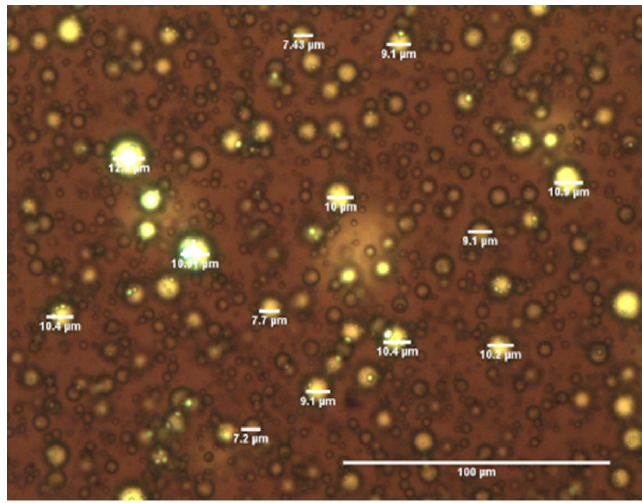
Figure 24. Sample N with 18% ( v / v ) water added. Dg average = 9.9 µm ± 0.01. The droplet size of emulsions was compared with samples of P system and an average of diameter of 16.6 µ m ± 0.01 was obtained and it is demonstrated in Figure 25.